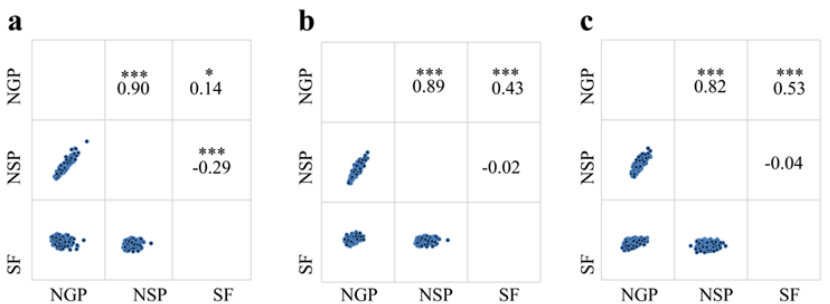
Figure 2. Correlation between different traits using mean value in Teqing/IRBB lines (TI) population ( a ), Zhenshan 97/Milyang 46 (ZM) population ( b ) and Xieqingzao/Milyang 46 (XM) population ( c ). The upper panel contains the correlation coefficients, and the lower panel contains the distributions of the three traits. * and *** represent significant level at 0.05 and 0.001, respectively.